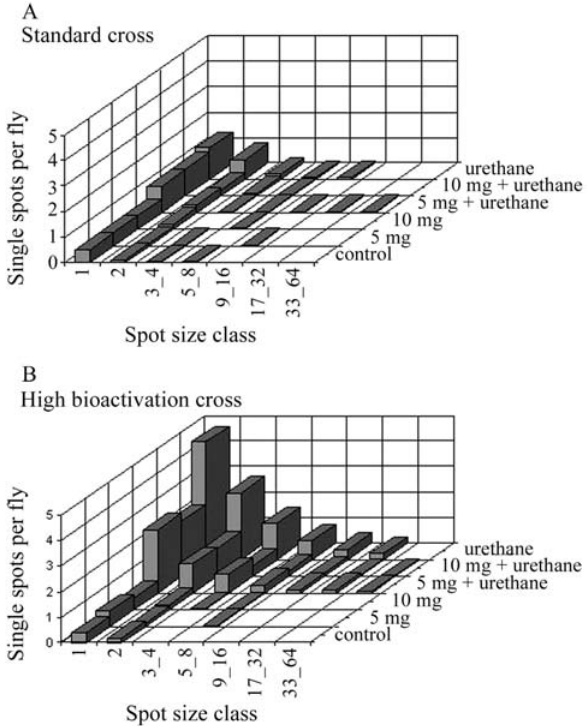
Figure 1 - Size distributions for single spots after chronic treatments with 5 mg mL -1 and 10 mg mL -1 of Mandevilla velutina crude extract (CE) and 0.89 mg mL -1 of urethane. (A): Standard (ST) cross. (B): High bioa- ctivation (HB)